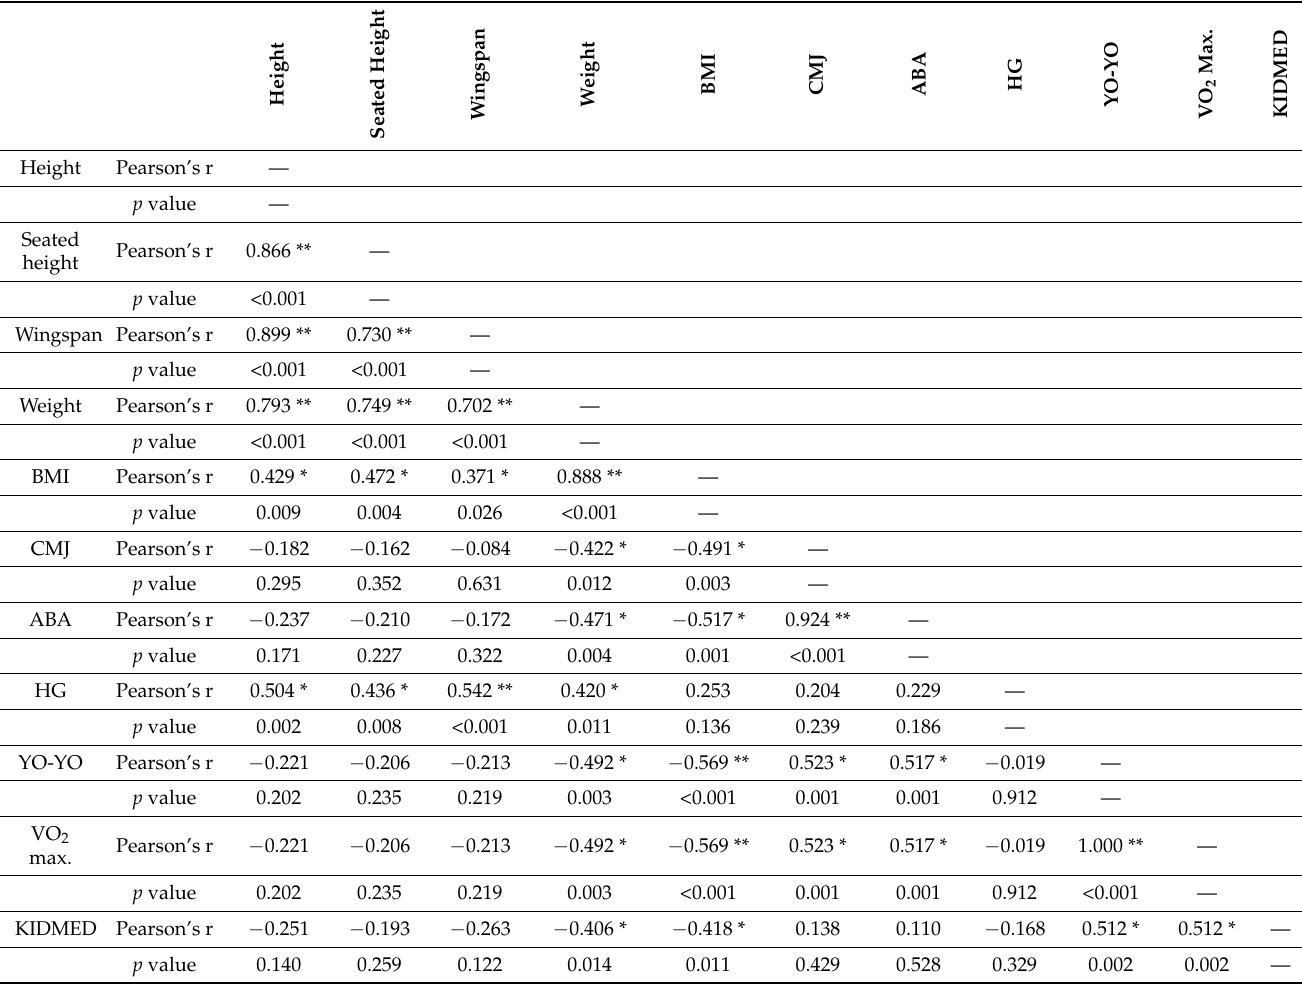
Table 4. Correlations between the variables included in the